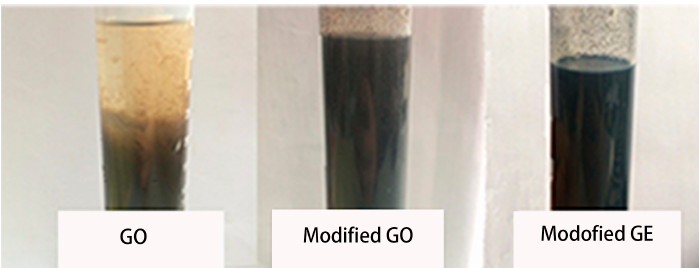
Figure 3. Dispersibility of GO, modified GO, and modified GE in ethanol after standing for 2 h.